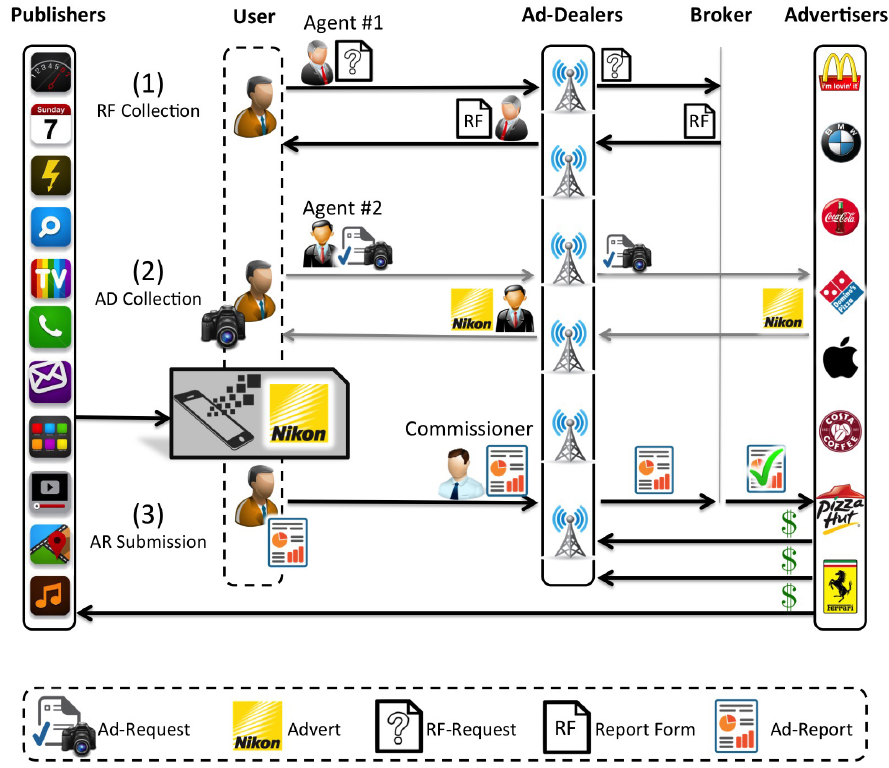
Figure 2. Decentralized advert reporting system over opportunistic